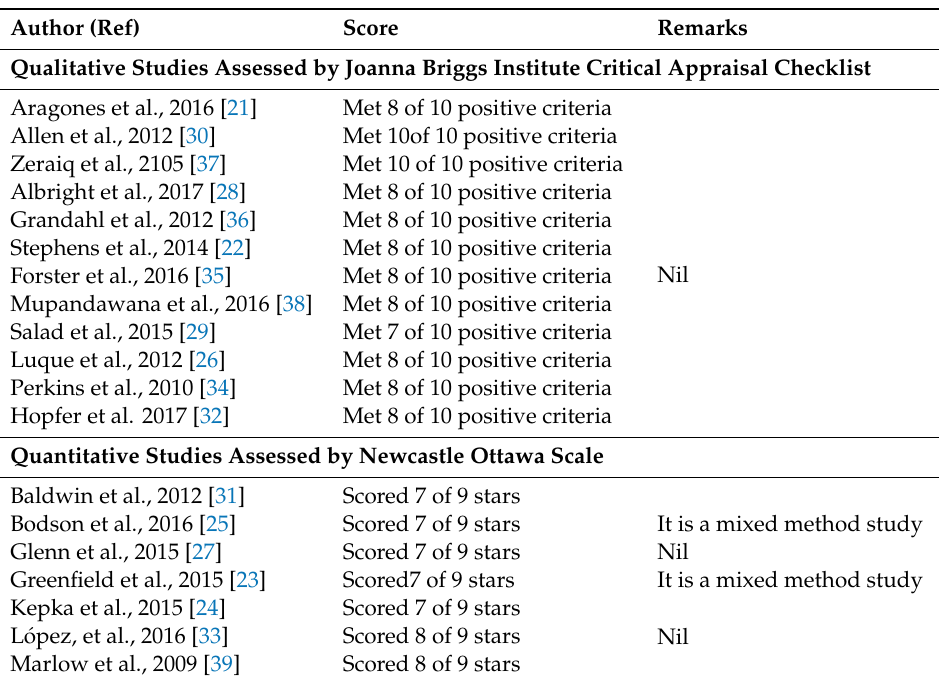
Table 5. Quality assessment of the included